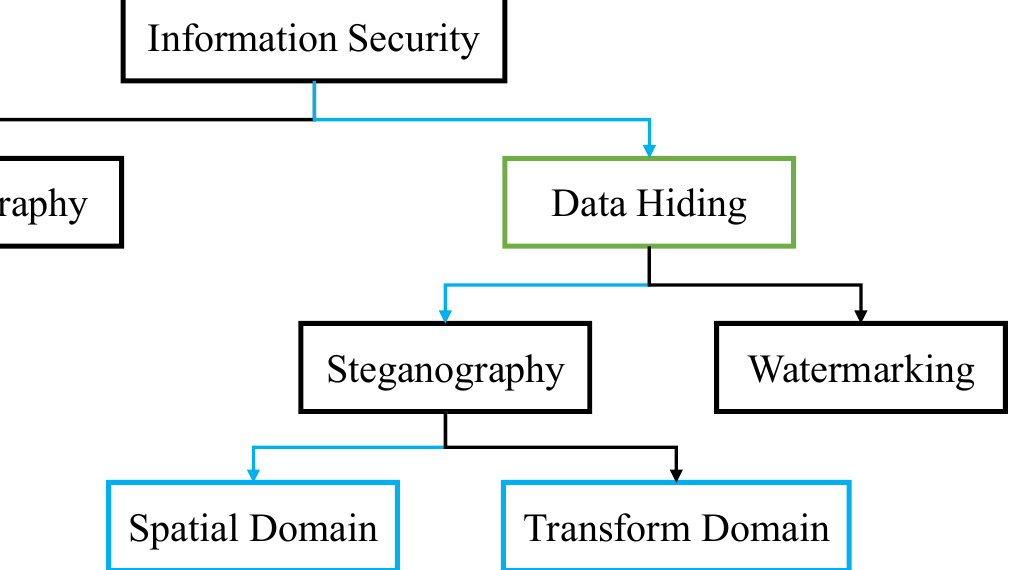
Figure 1. Classification of information security.